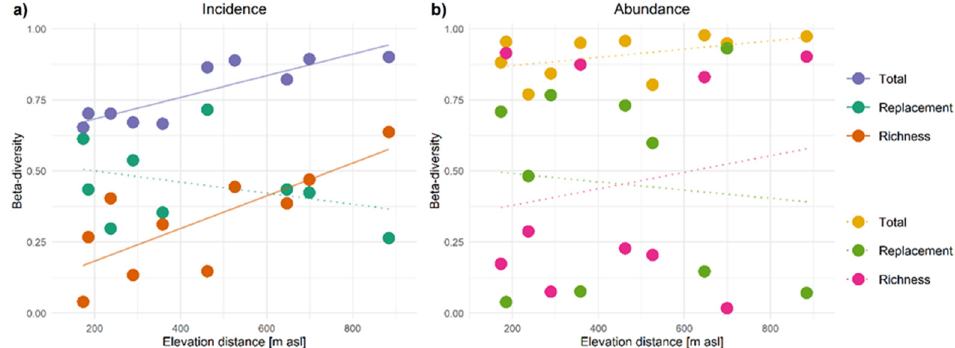
Figure 4. Patterns of total beta diversity and its replacement and richness components over the elevational distance (i.e., difference in m a.s.l.) between sites on the five-site elevation transect for all species, providing; ( a ) incidence-based, and ( b ) abundance-based beta diversity estimates. The linear trendlines are shown as solid lines for species groups where p -values are <0.05 and indicated with dotted lines when p ≥ 0.05.